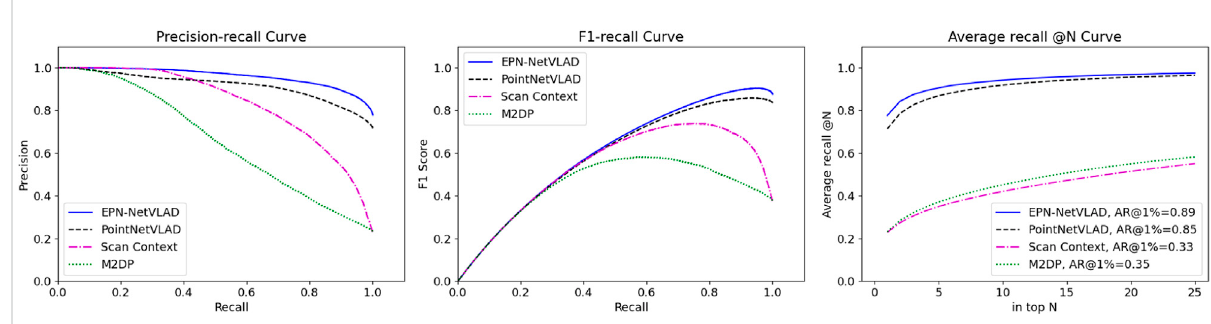
TABLE7Experimentresultshowingtheaveragerecall(%)attop1%for each of the models. Both methods are only trained on Oxford (Maddern et al., 2017) and tested on other different data sets (Uy and Lee, 2018).